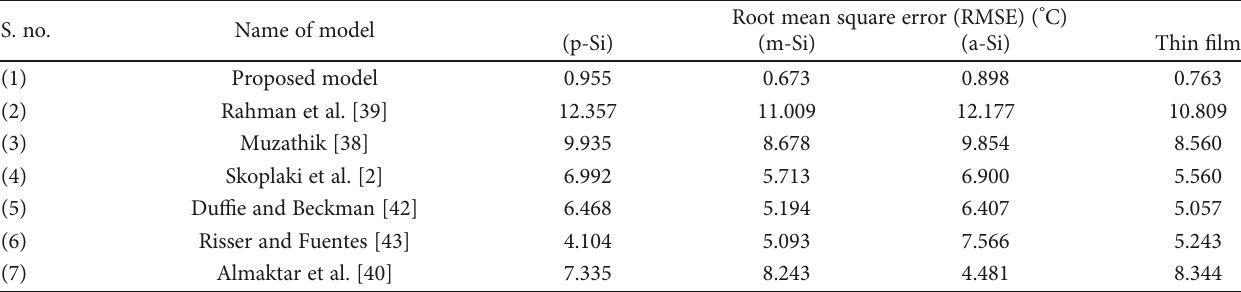
Table 7: Root mean square error (RMSE) of each PV module in winter. S. no.